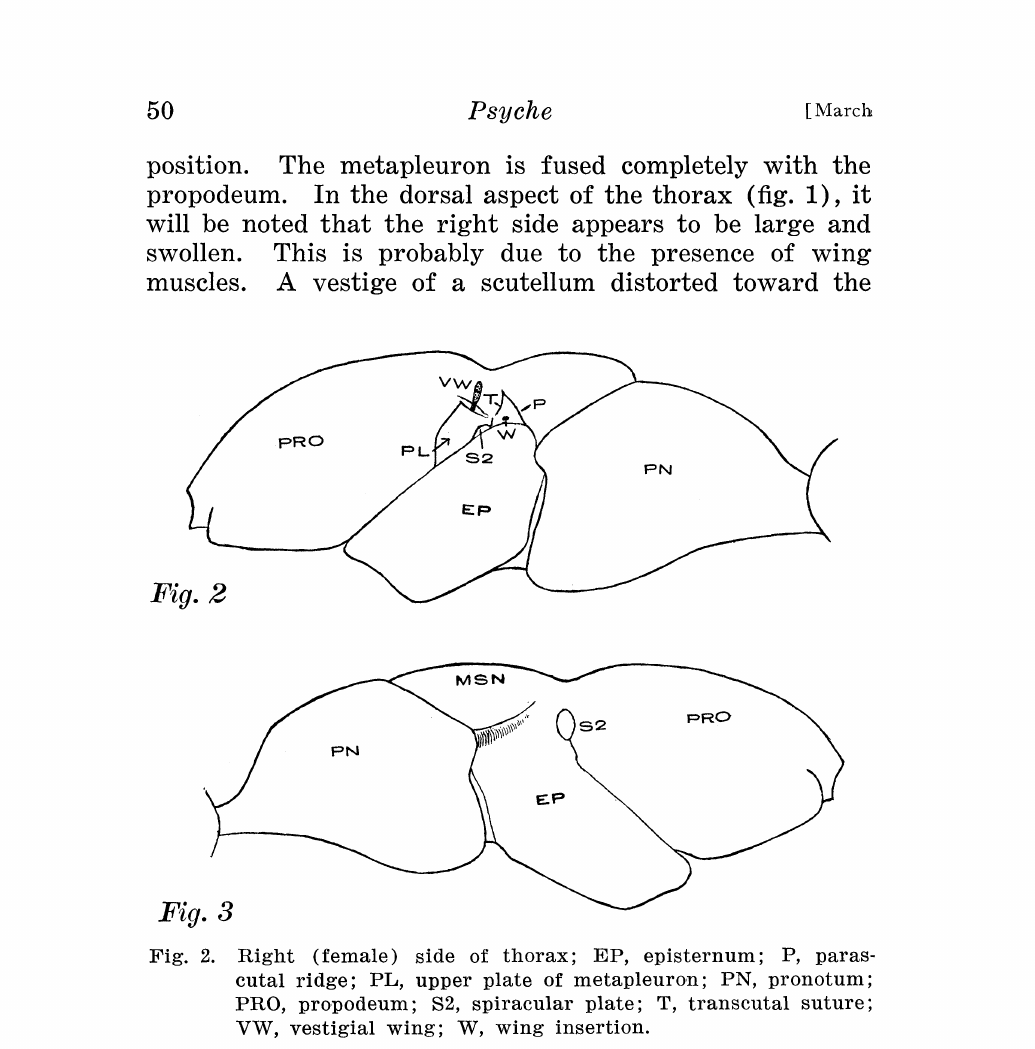
right side may be seen in the specimen as well as a portion of a distinct